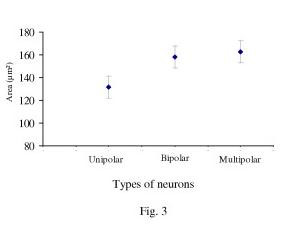
Relation between mean, standard error of mean and deviation values of sizes (μm2) of the three types of NADPH-positive cardiac neurons (unipolar, bipolar and multipolar) of the mouse atria.